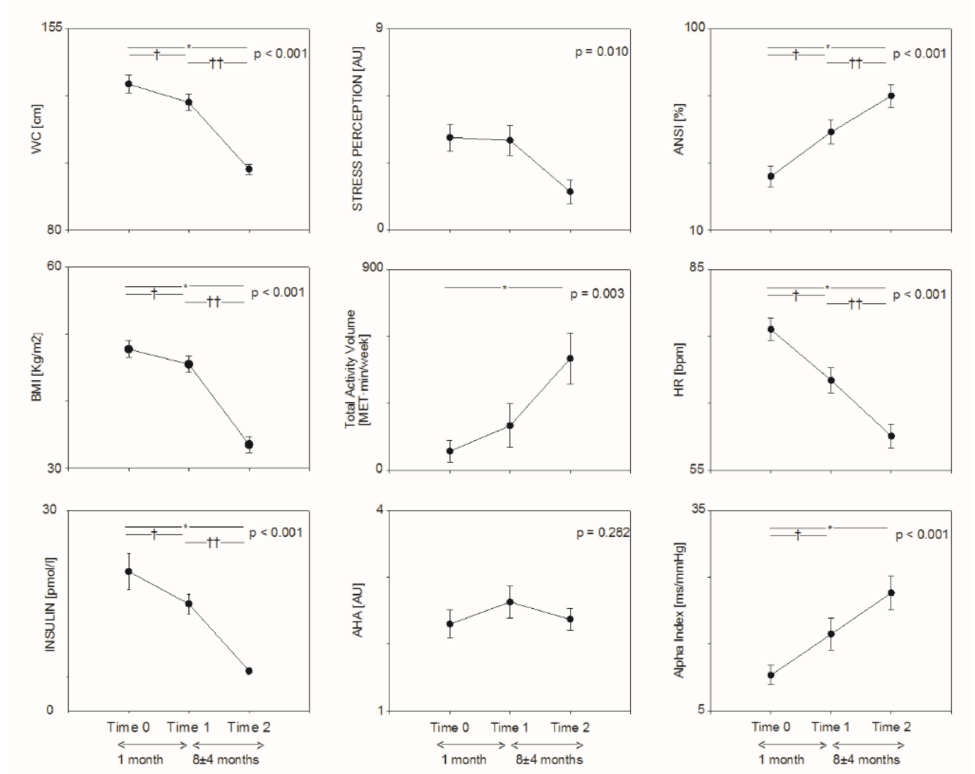
Figure 1. Changes in metabolic ( left panels), lifestyle ( middle panels) and autonomic ( right panels) parameters from baseline (Time 0) to Prehabilitation (Time 1) and after bariatric surgery (Time 2). * T2 vs. T0: p < 0.05; † T1 vs. T0: p < 0.05; †† T2 vs. T1: p <